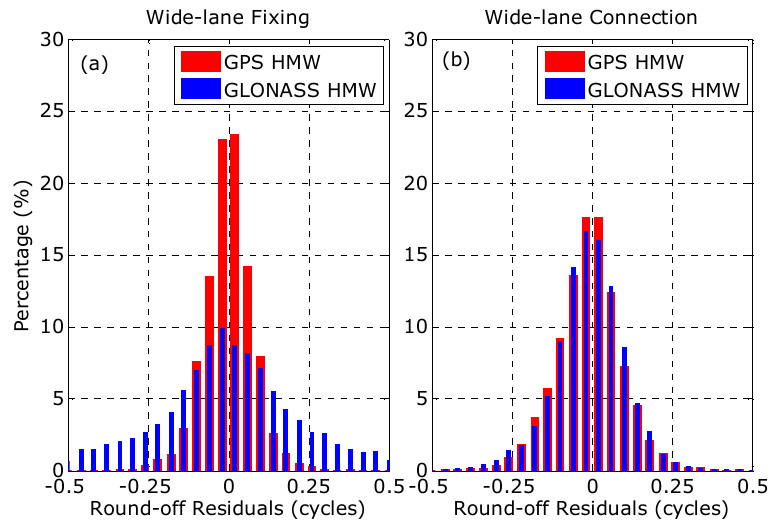
Figure 4. Distributions of a posteriori residuals for GPS and GLONASS when performing wide-lane ambiguity fixing ( a ) and connection ( b ) using the Hatch–Melbourne–Wubbena (HMW) combination.